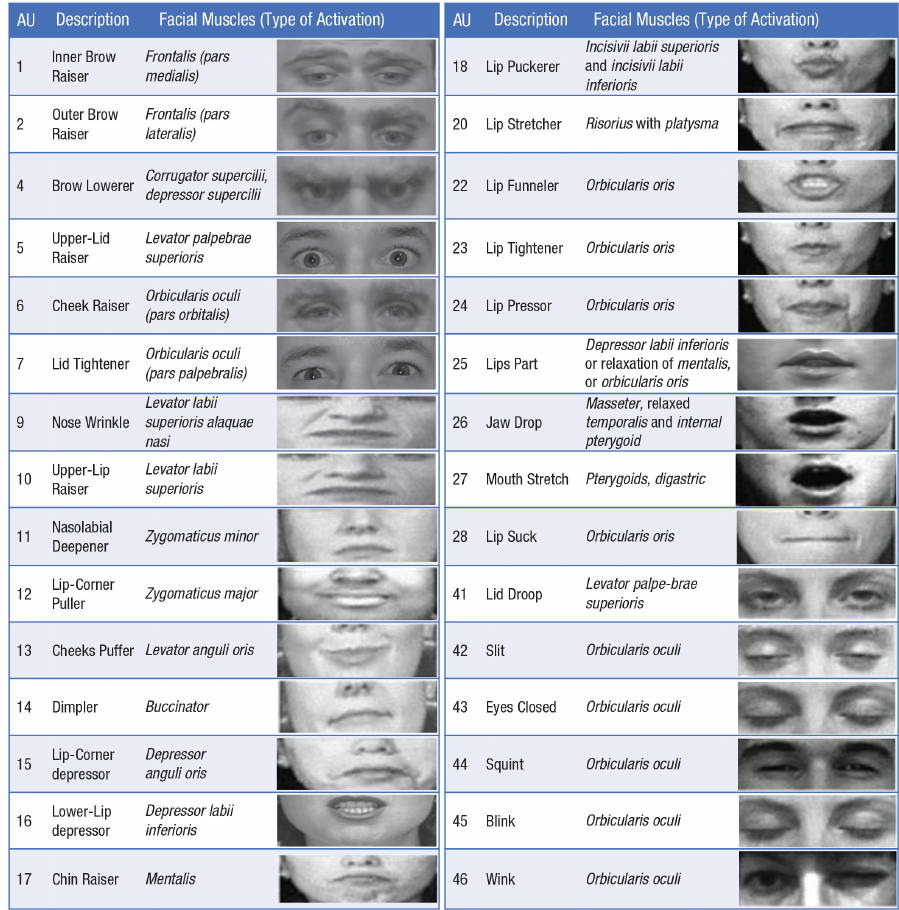
Figure 1. Facial Action Coding System [40] codes for adults. AU = action unit. Images for AUs are reproduced from